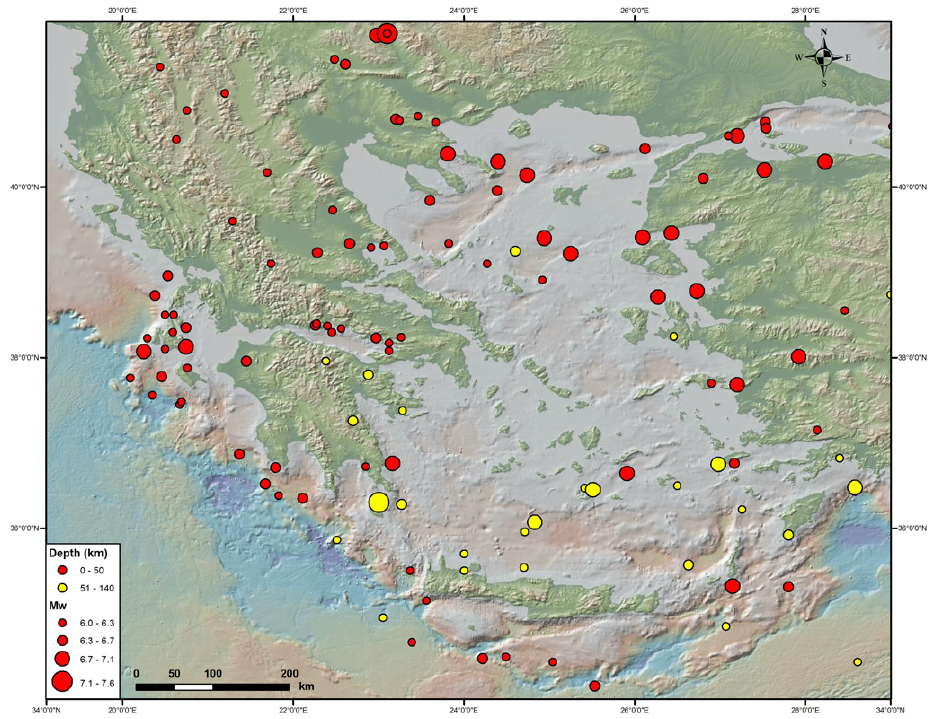
Fig. 3. Spatial distribution of the epicentres of events with M w ≥ 6 . 0 in Greece and adjacent areas during the period 1900–2009.